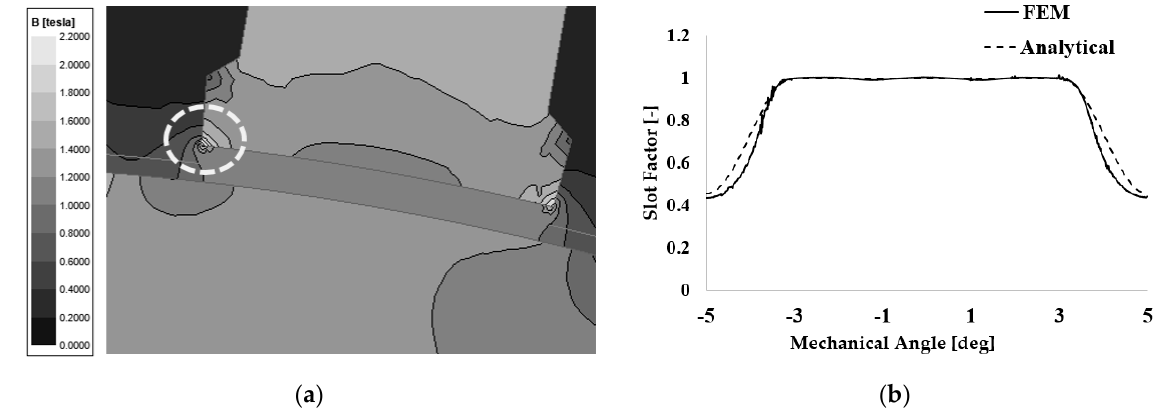
Figure 7. Magnetic field distribution: ( a ) flux density of the teeth and shoe, and ( b ) slot factor.